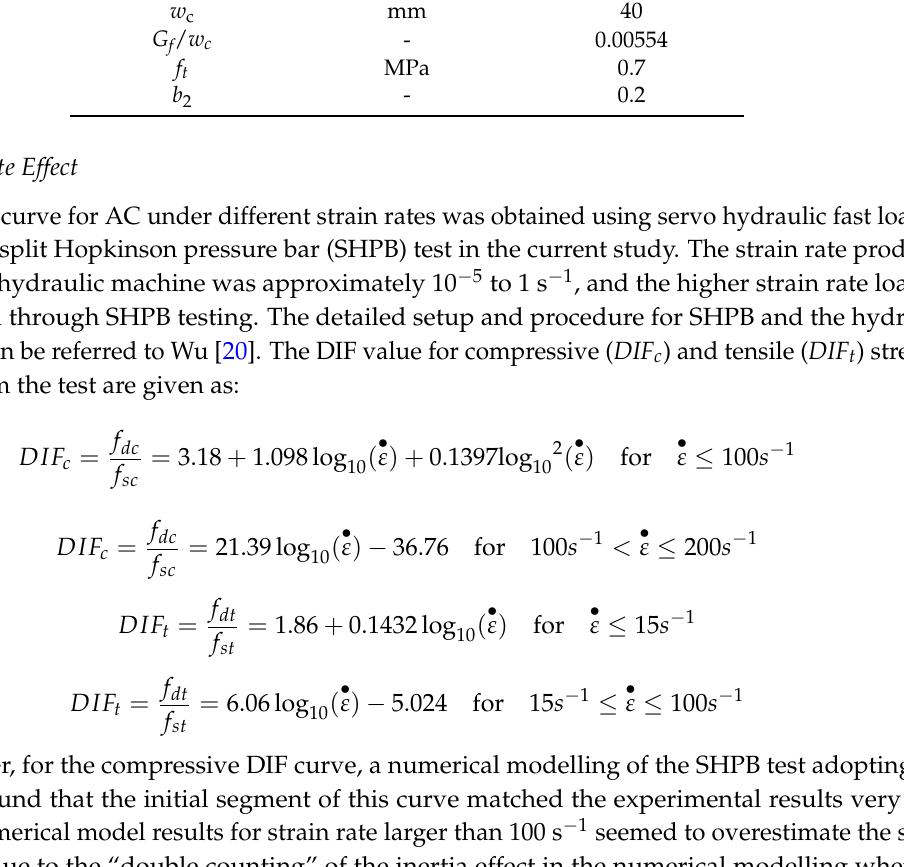
Table 2. Parameters from the single-edge notched beam test (SNB) and single element simulation. Parameters Unit Value K IC MPa · mm 1 / 2 12.2 ν -